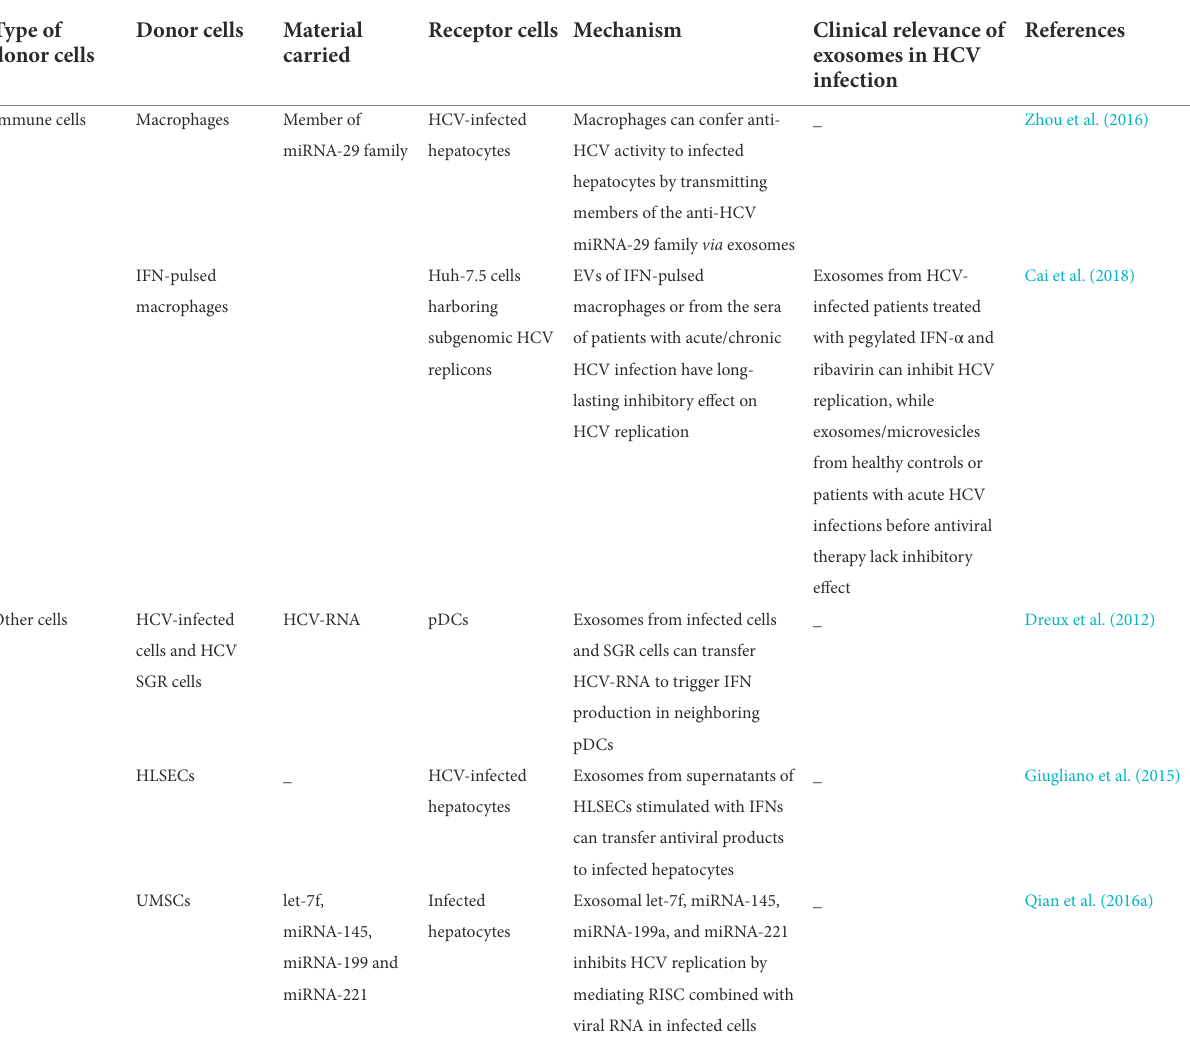
TABLE 4 Exosomes limit HCV